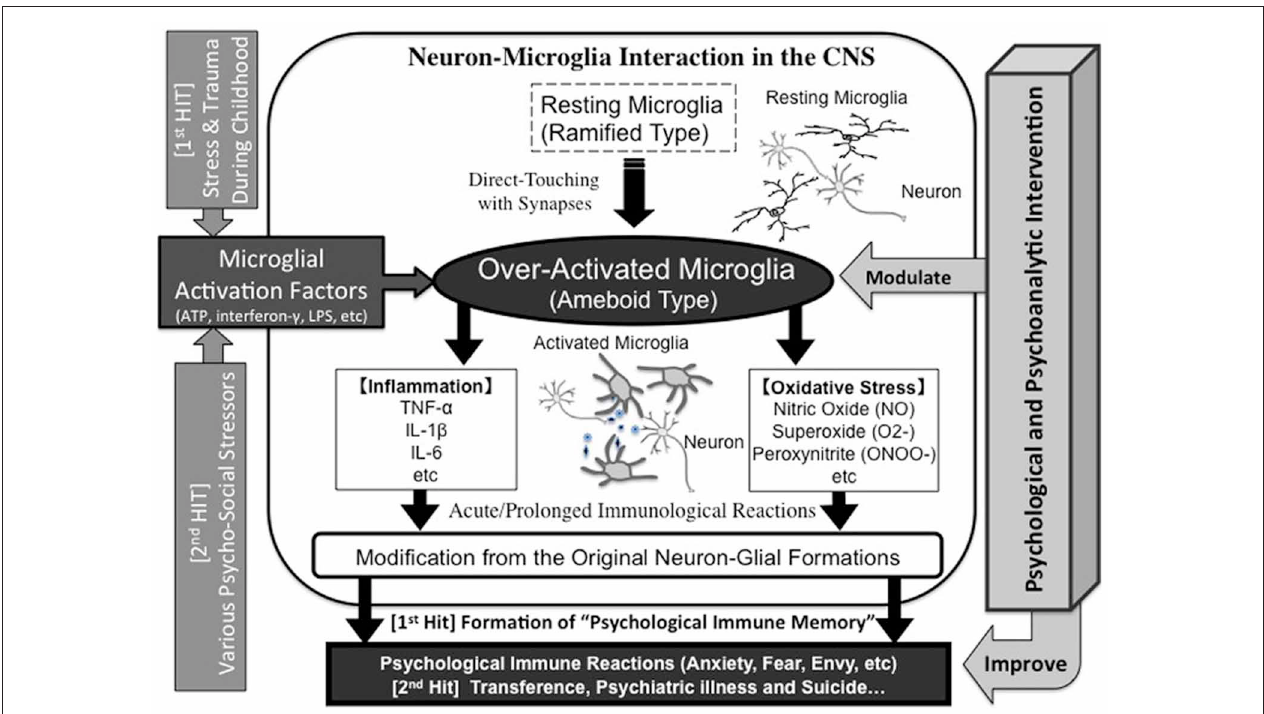
FIGURE 4 | Neuron-microglia interaction during “psychological immune memory/reaction.” Strong psychosocial stress such as trauma during childhood may over-activate microglia, which induce a variety of inflammatory/oxidative-stress factors and result in damaging the original neuron-microglial formations. Finally, novel neuron-microglial networks will be formulated. This reaction is memorized as “psychological immune memory”. When similar psychosocial stress, even